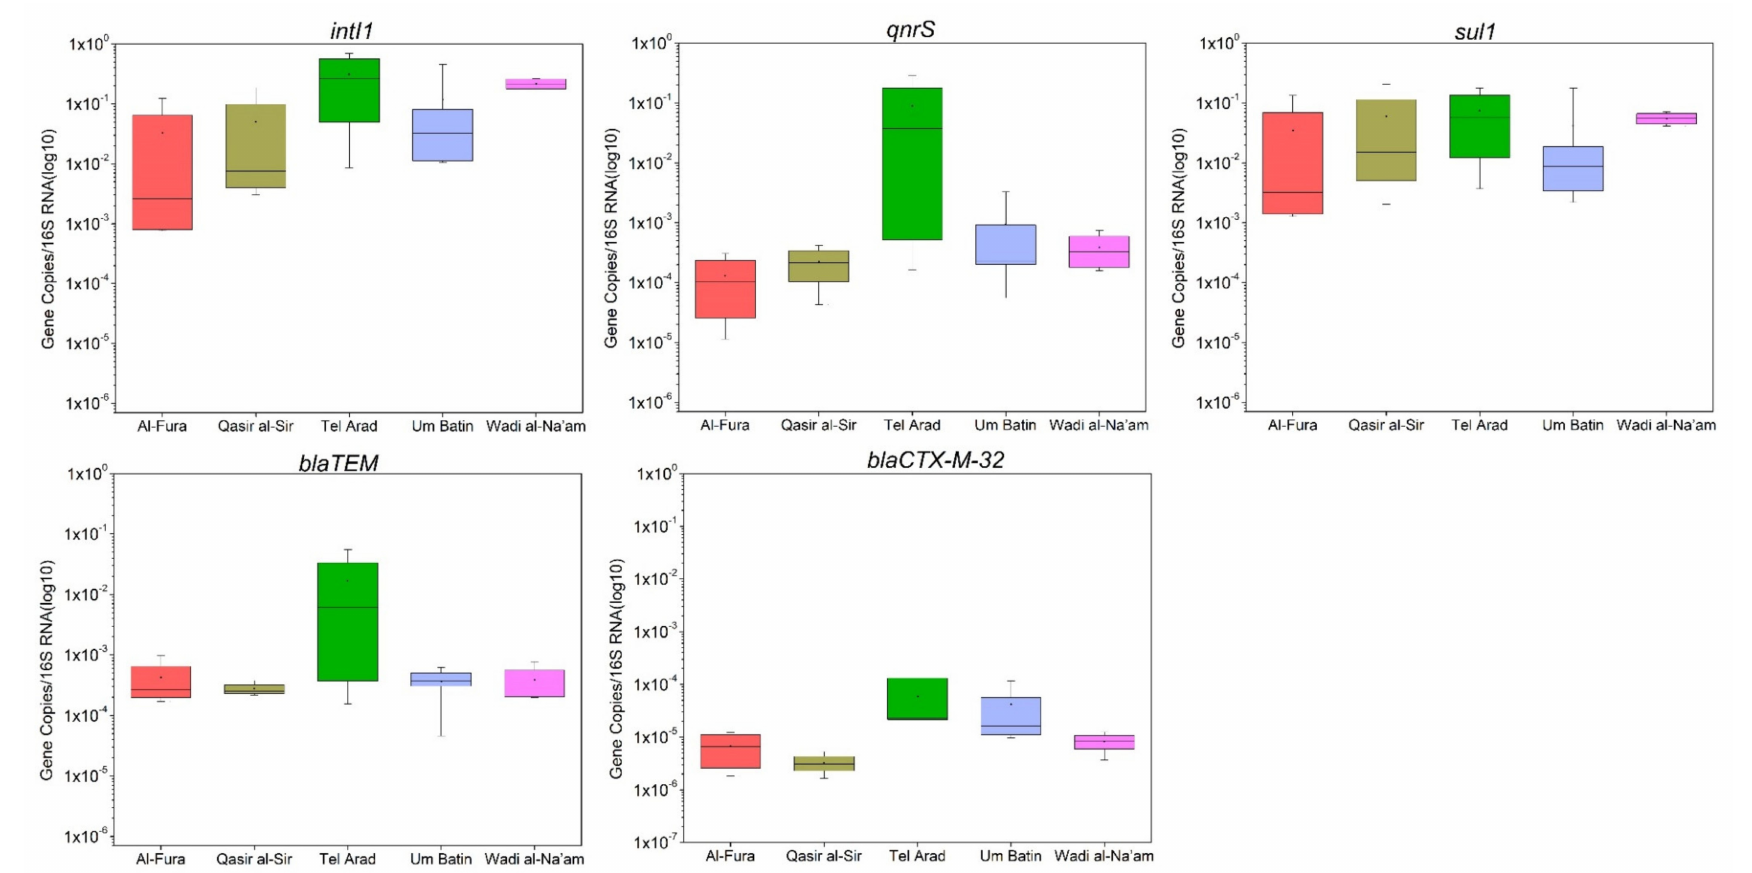
Figure 2. Relative abundance of antimicrobial resistance genes in GW samples collected from five di ff erent villages. Data shown as relative gene copies normalized to the copies of 16S rRNA genes from each sample. Relative abundance of ARGs are shown as box plots (boxes- show interquartile range, mean and median are shown as small square symbol and horizontal line